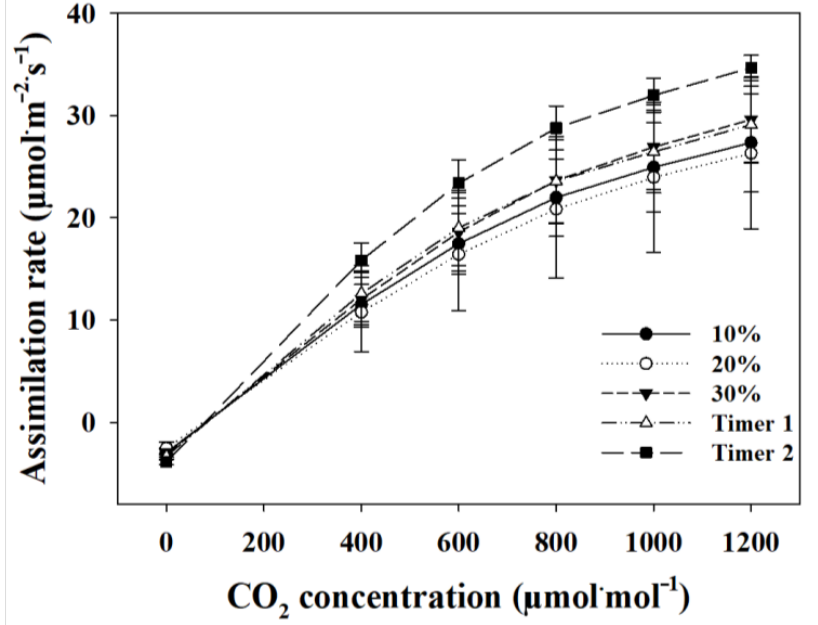
Figure 5. CO 2 response curves of strawberry ‘Kuemsil’ as affected by the nutrient solution supplying system using different drainage rate levels and timer (Drainage rate 10%, 20%, or 30%; Timer 1, timer set for 4 applications daily; Timer 2, timer set for 6 applications daily). Vertical bars indicate standard errors of the means ( n = 3).